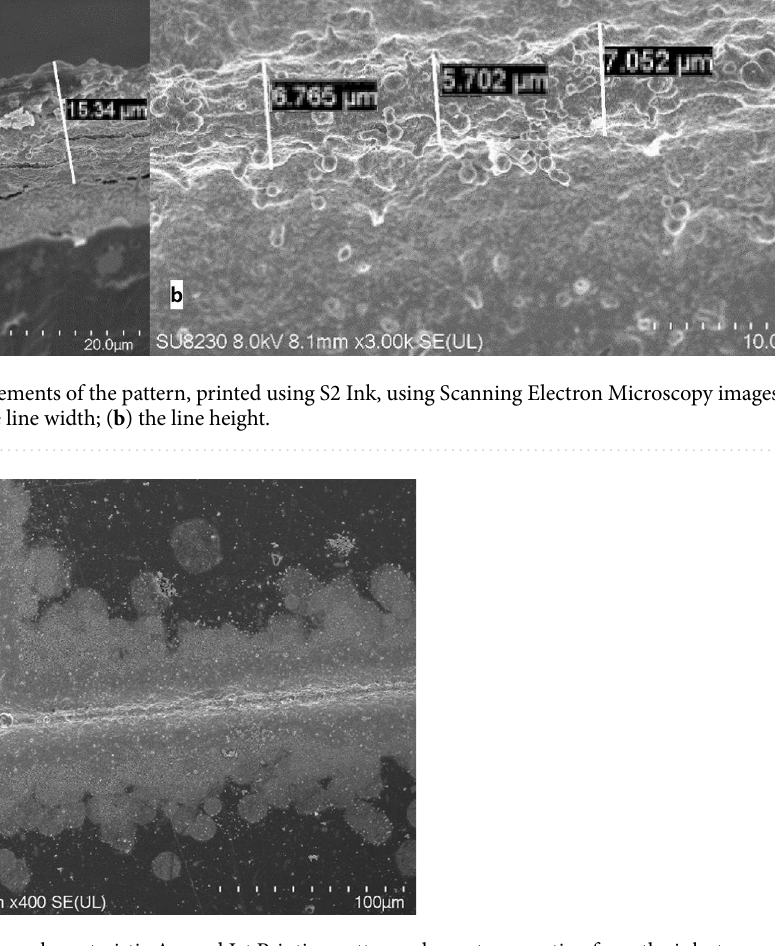
L —line length. R —measured resistance.